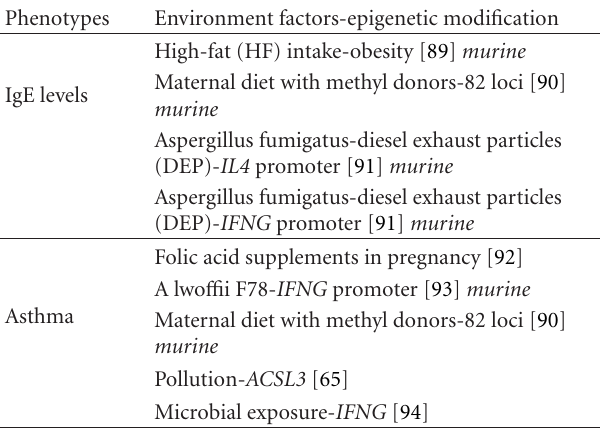
Table 4: Environmental modification of epigenetic program on IgE production and